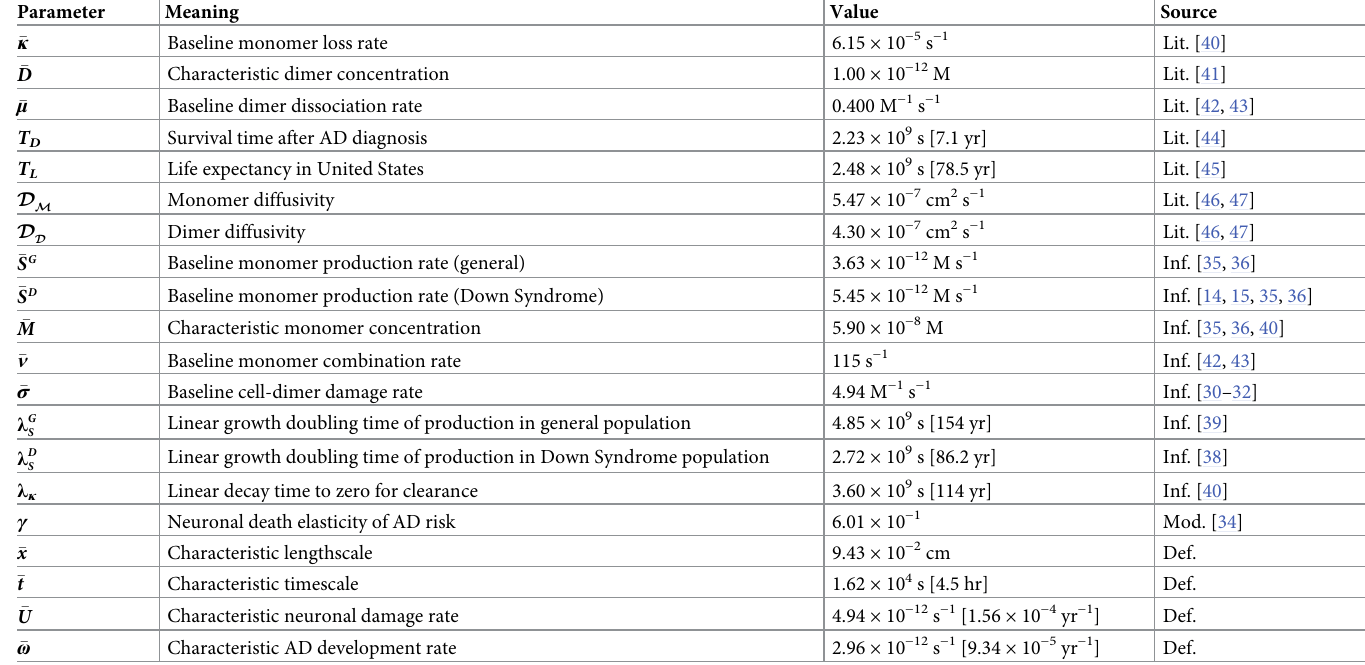
Table 1. Values of parameters within the model. See Fig 2 for an explanation of how these values were determined and their sources; Bars (e.g., � S ), indicate a quantity rep- resentative of that in a healthy brain; Lit . denotes values listed in literature; Inf . denotes values inferred or fit from published data; Mod . indicates a value fit from our model with reference to literature; Def . denotes the definition of a value used in our study in various calculations, derived from other quantities in the